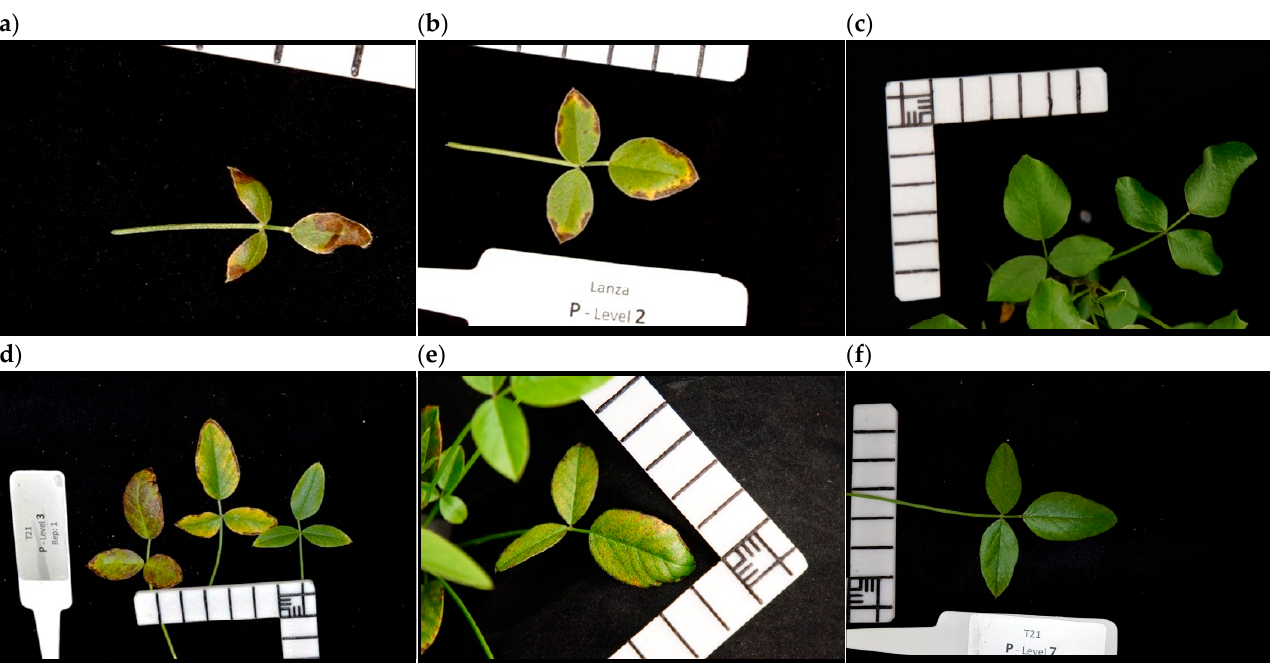
Figure 6. Images of leaves taken from Lanza ® tedera ( a – c ) and Palma ( d – f ) grown in soils with deficient levels of phosphorus ( a , b , d , e ) and adequate phosphorus ( c , f ). Symptom progression from younger to older leaves (R to L) is shown in panel ( d ).